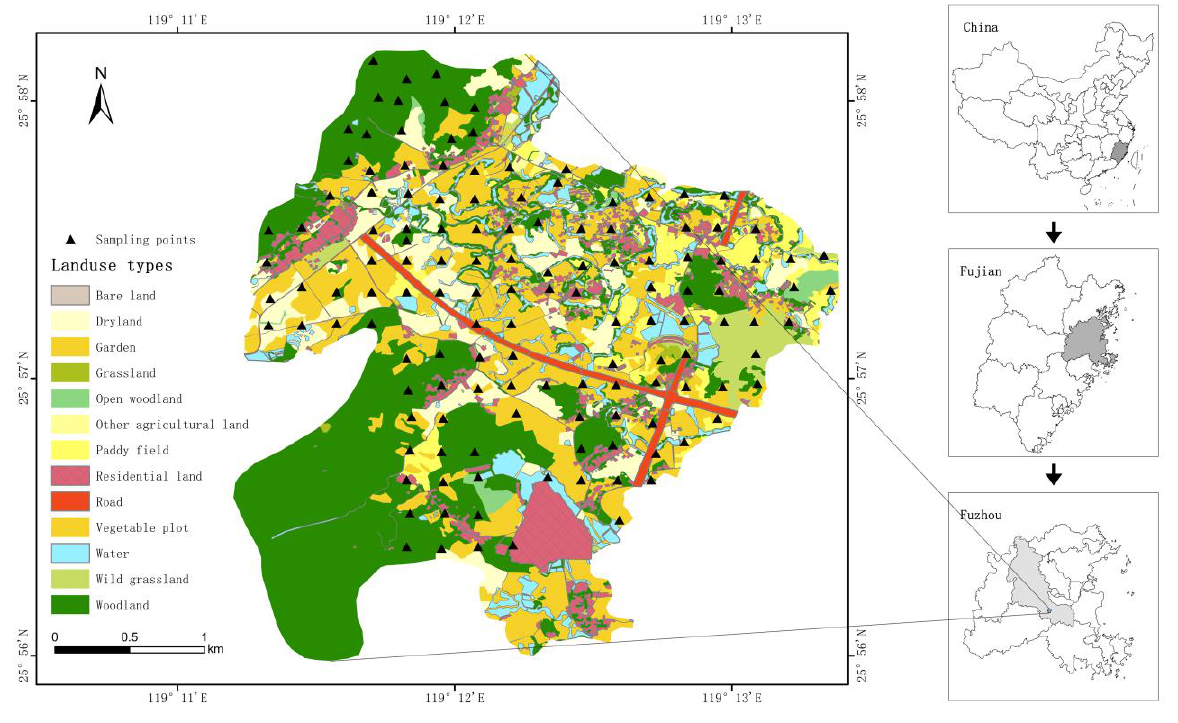
Figure 1. Location of the study